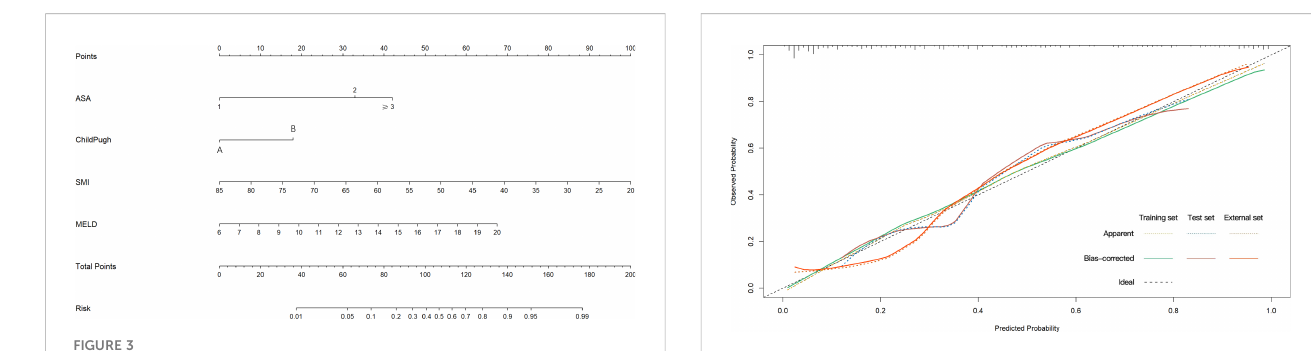
FIGURE 5 Calibration curves for the prediction of PHLF. PHLF, post-hepatectomy liver